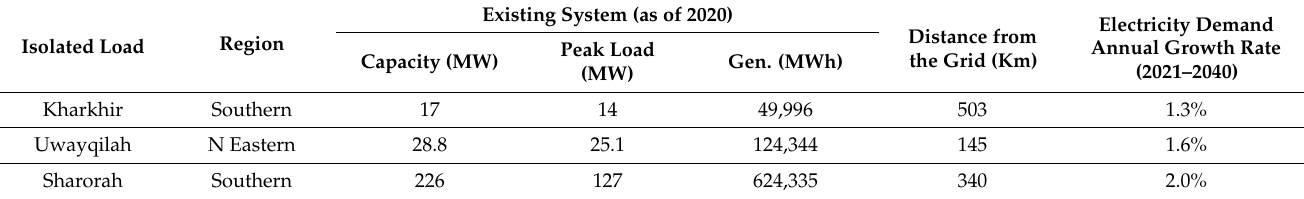
Table 1. The major isolated areas to be